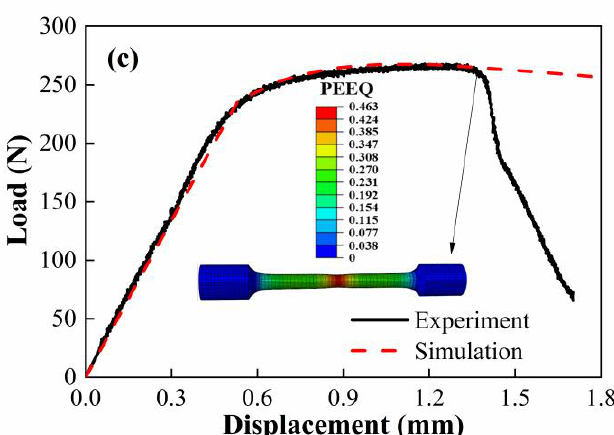
Figure 8. Equivalent plastic strain cloud diagram of smooth round bar sample at fracture time. ( a ) M20, ( b ) M50 and ( c ) M80.